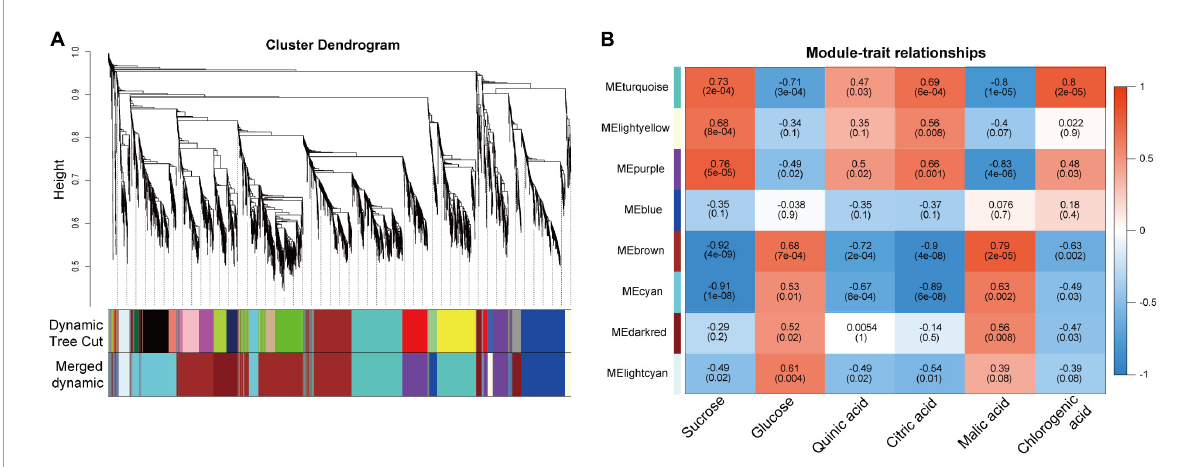
FIGURE5 Result of gene coexpression modules associated with sugars and organic acids in pineapple fruits at different developmental stages of M and B. (A) Clustering dendrogram presenting 11 modules of coexpressed genes based on WGCNA. (B) Correlations coefficient and significance between modules and sucrose, glucose, quinic acid, citric acid, malic acid, chlorogenic acid, where each grid contained the corresponding correlation and p -value.